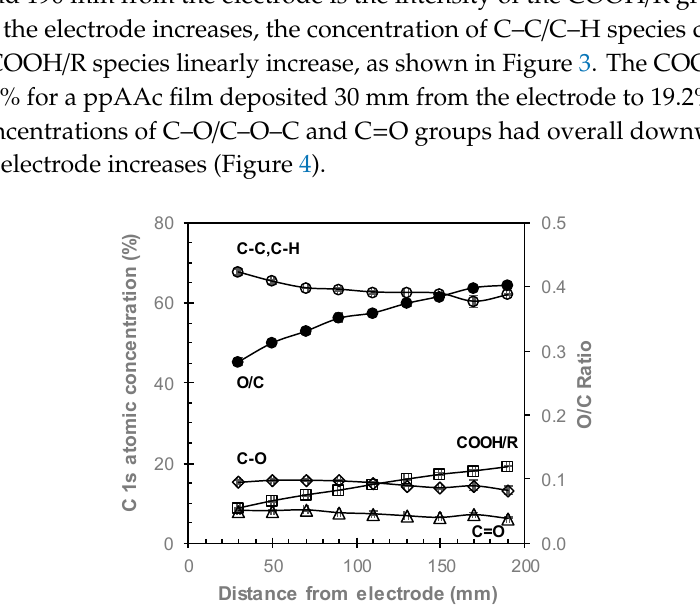
Figure 3. XPS C1s atomic concentrations ( ○ —C–C/C–H, □ —COOH/R, ◊ —C–O,/C–O–C and ∆ —C=O) and O/C ratio ( ● ) for ppAAc films as a function of distance from the electrode (error bars ± standard deviation).